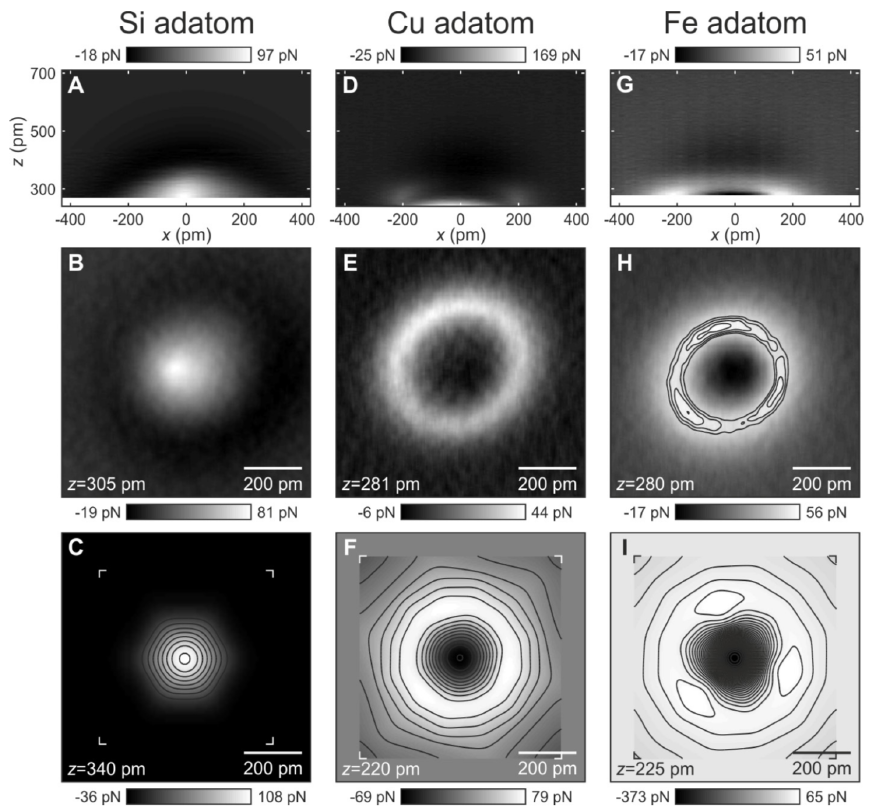
Figure 18. Experimental and calculated forces for three different adatoms in side and top views. Top row (side view): Experimental vertical forces F z in the xz plane between a CO-terminated AFM tip and ( A ) a Si adatom, ( D ) a Cu adatom, and ( G ) a Fe adatom on Cu(111). Middle row (top view): Constant-height force data in the xy plane between a CO-terminated tip and ( B ) a Si adatom, ( E ) a Cu adatom, and ( H ) a Fe adatom on Cu(111) taken at z positions, as indicated in the left bottom corner, respectively. Bottom row (top view): DFT calculations of F z in the xy plane between a CO molecule tip and ( C ) a Si adatom, ( F ) a Cu adatom, and ( I ) a Fe adatom on Cu(111). The three local maxima on the experimental data ( H ) and DFT data ( I ) for the Fe adatom are located above the hollow sites of the Cu(111) substrate underneath (see Figures S5 and S6 in [71]). Note that the color scale is the same for the force data in the top and middle rows. The color scale in the bottom row is different in order to maximize the contrast. Scale bars, 200 pm. Adapted with permission by American Association for the Advancement from Figure S11 in